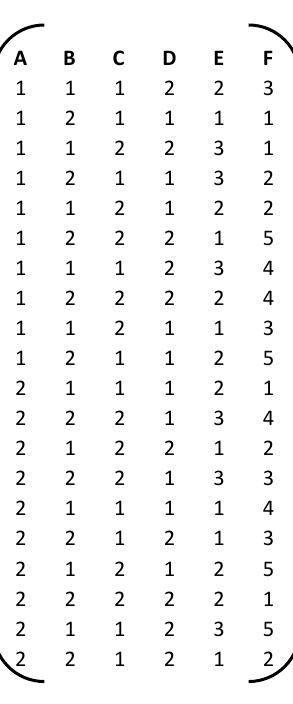
Figure 6. EA (20, 2 4 3 1 5 1 ). Table 3. Model matrix for EA (20, 2 4 3 1 5 1